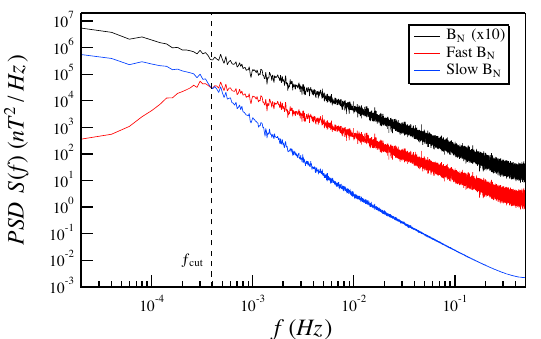
Figure 3. The power spectral density (PSD) of the original time series of the normal component together with those corresponding to the filtered time series below and above the frequency cut-off f cut . The PSD of the normal component has been scaled by a factor 10 for visual purposes.